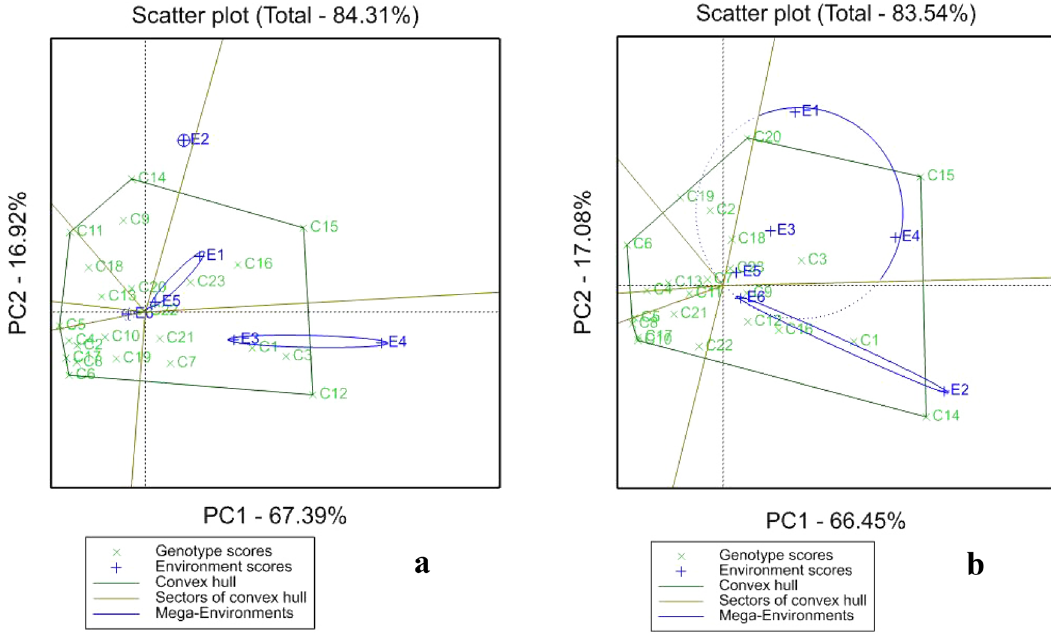
Figure 2. Outstanding performances of the sweetpotato clones for storage root yield in the different environments (“which won where”) and the delineated mega environments under drought ( a ) and under well- watered ( b )